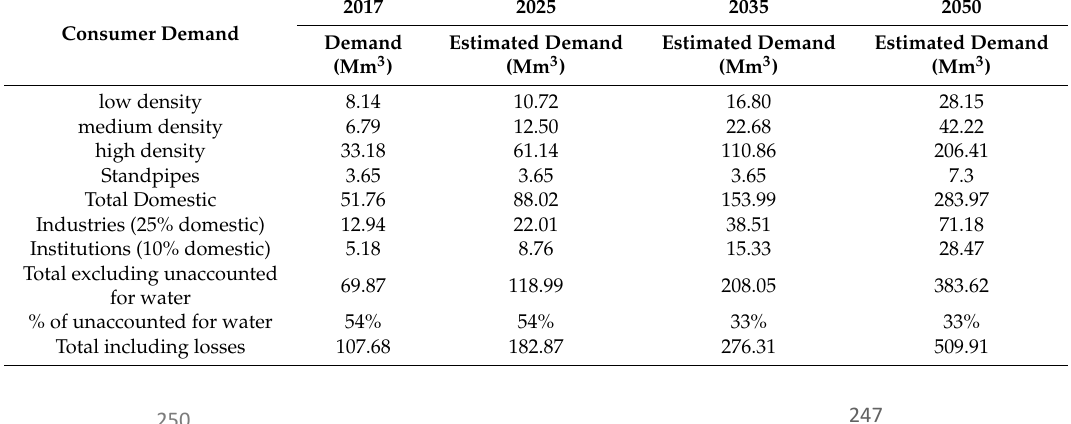
Figure 5. Present and projected water demand for Kano River Irrigation Project (KRIP).